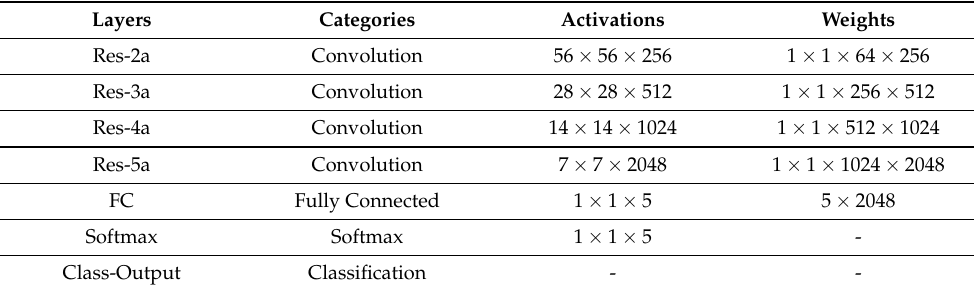
Table 5. ResNet-50 network used for guava disease detection.